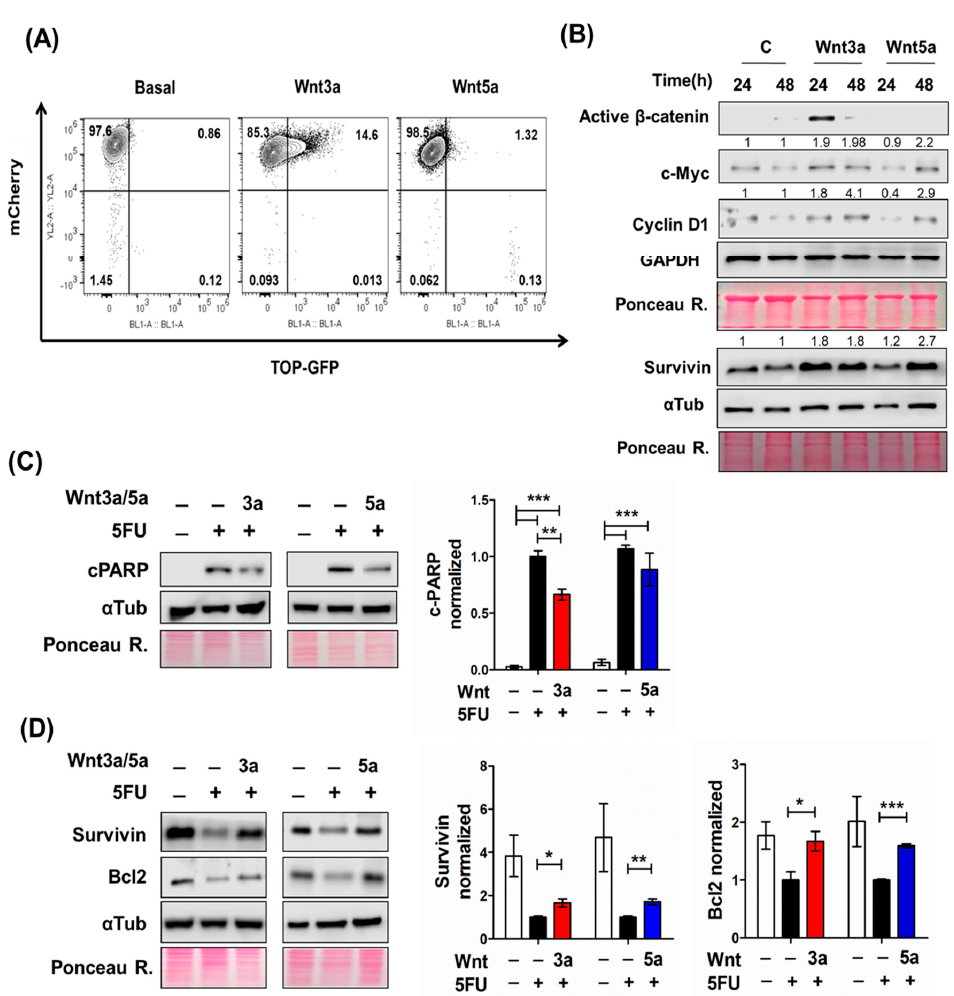
effect from other expressed TCF proteins during spheroid formation.